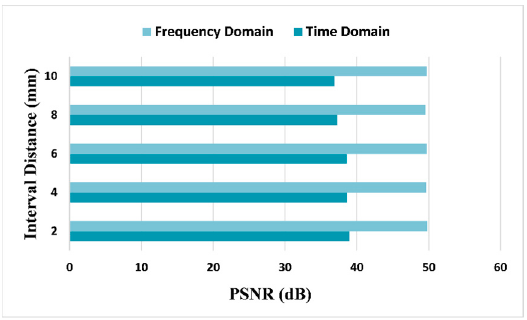
Figure 10. Comparative PSNRs between different defects interval spaces, using 25 MHz SR in time domain and 20 MHz SR in frequency domain, and CR is 70% for both domains.